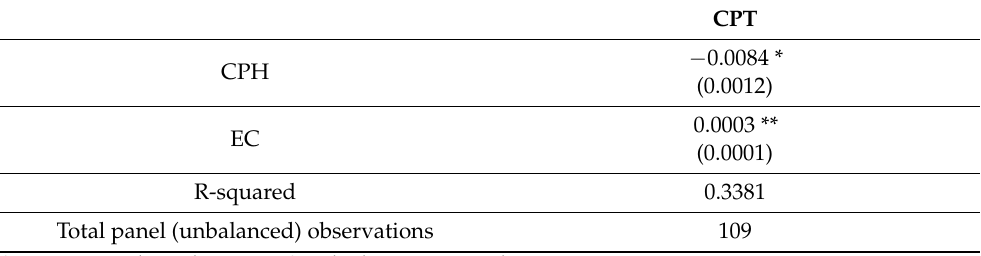
Table 4. Empirical